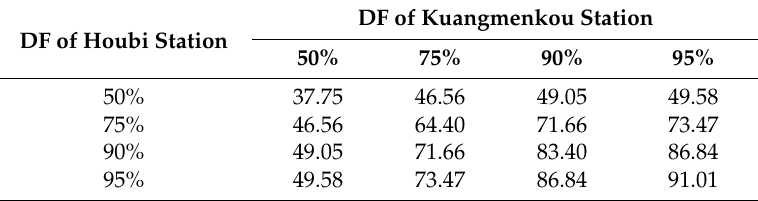
Table 7. The joint probabilities of annual runoff of two tributaries at given design frequencies by Frank copula